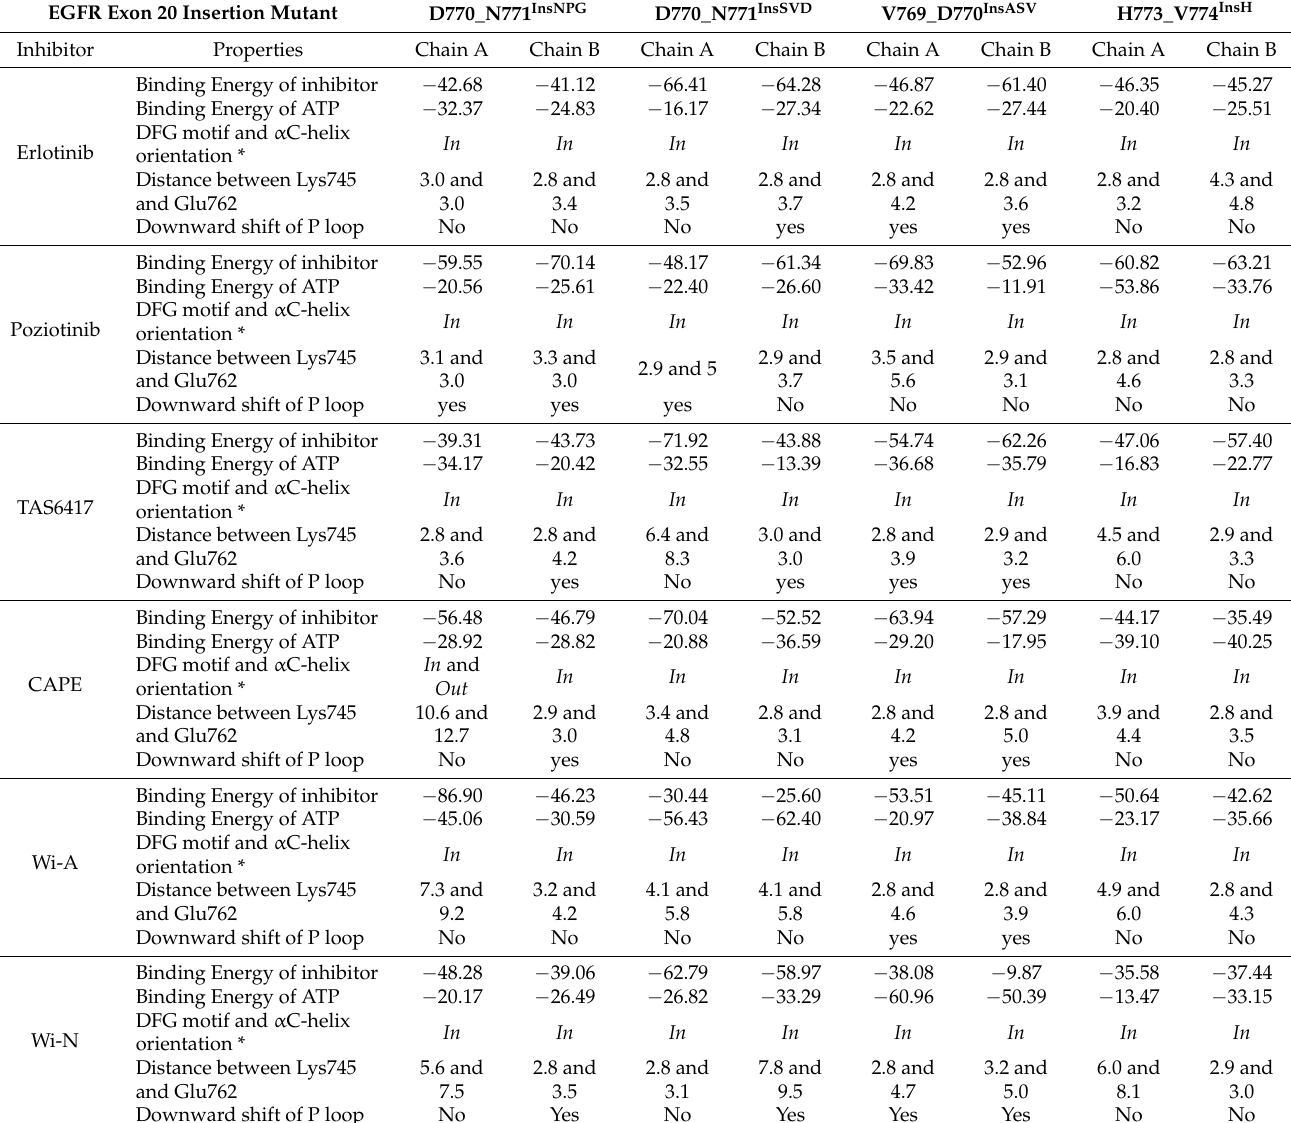
Table 1. Influence of compounds on different structural properties of EGFR exon 20 insertion mutants as ATP competitive inhibitors. The binding free energy is given in Kcal/mol and the distances are in